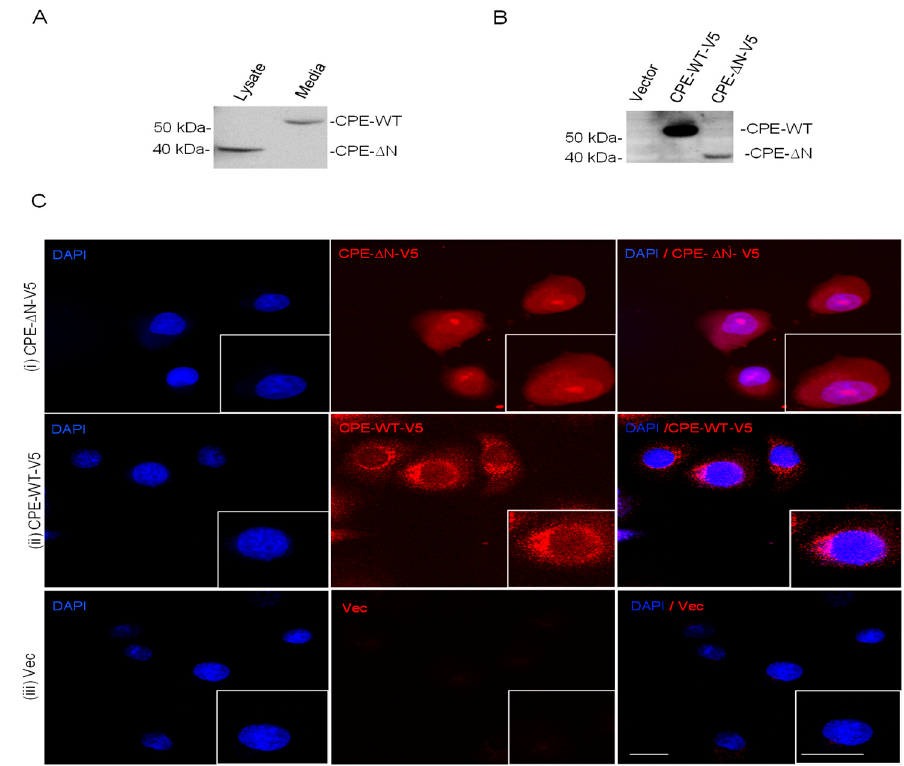
Figure 2. Cellular localization of CPE- ∆ N and CPE-WT in Panc-1 cells. ( A ) Western blot showing CPE-WT in the concentrated medium of the Panc-1 cells but not in the cell lysate. Note, CPE- ∆ N was found in the cell lysates but not in the secretion medium. ( B ) Western blot showing expression of CPE-WT-V5, CPE- ∆ N-V5, and vector (Vec) alone in the stably transfected Panc-1 cells using anti-V5 antibody. Full-length blots are presented in Supplementary Figure S2A,B ( C ) Representative confocal images of Panc-1 cells stably expressing CPE-WT-V5 and CPE- ∆ N-V5 or vector alone (control). Anti-V5 (red) and nuclear staining with DAPI (blue) are shown. Note V5 tag staining in the cells expressing CPE- ∆ N-V5 was localized in the nucleus overlapping with DAPI stain, as well as in the cytoplasm (top panels) while V5 staining in cells expressing CPE-WT-V5 was localized exclusively in the cytoplasm (middle panels). Panc-1 cells expressing vector alone show only background staining for V5 since this tag is not in the construct (lower panels). Inset shows high magnification image of a single cell. Scale bar = 20 µ m.